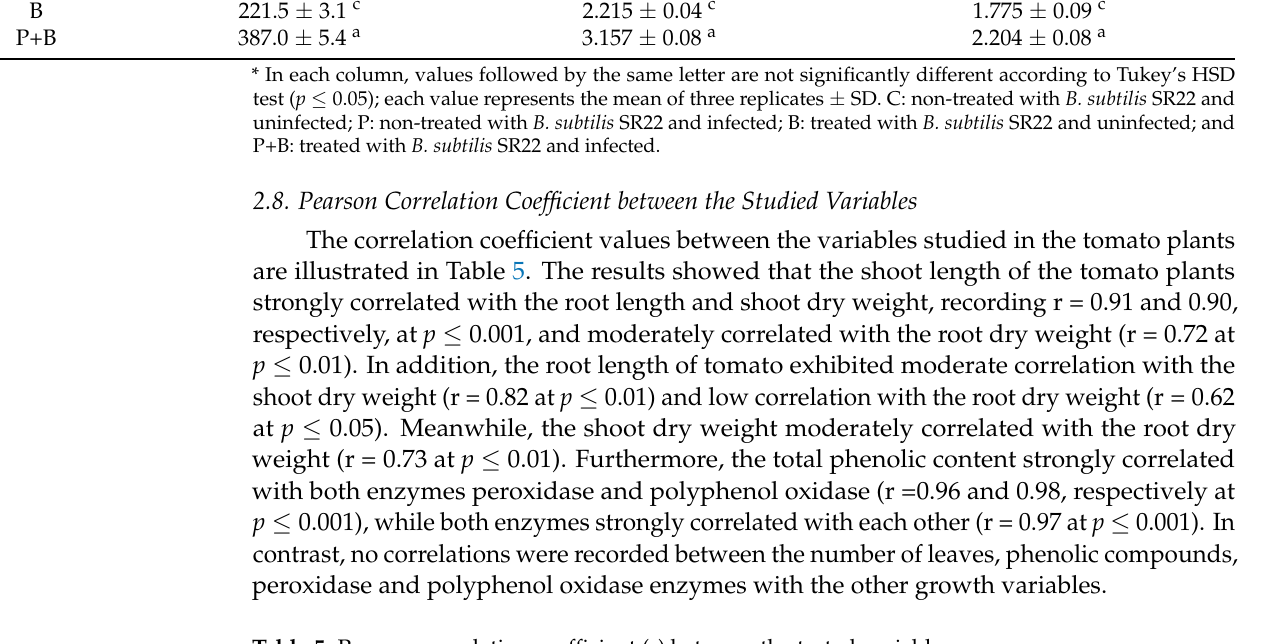
Table 5. Pearson correlation coefficient (r) between the tested